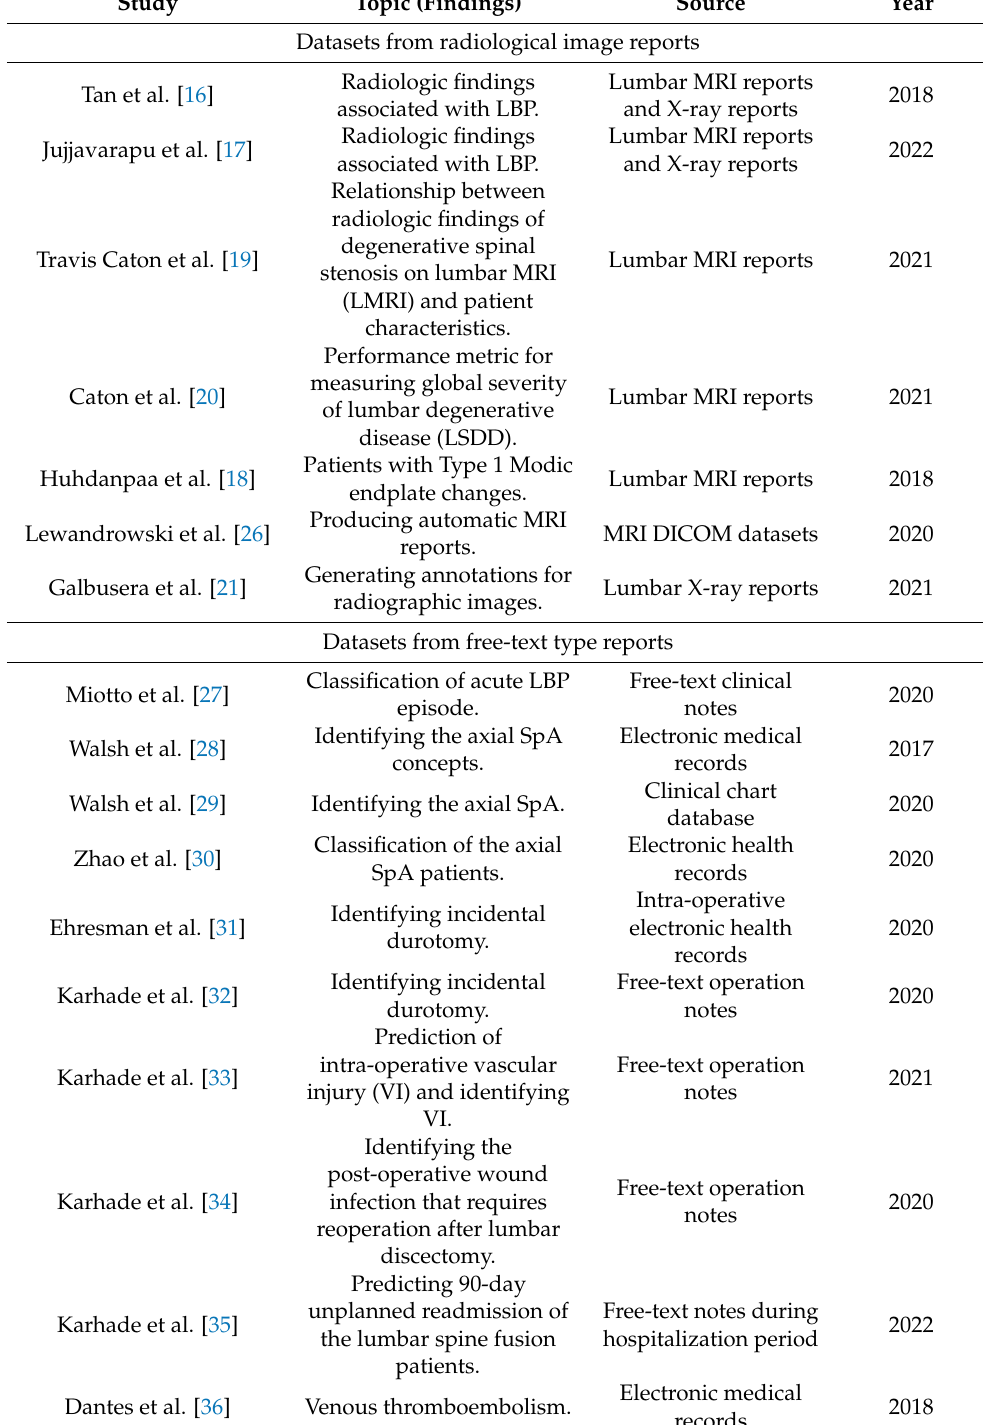
Table 4. Classification of previous studies to develop NLP systems regarding LBP pain, spinal disease, and complications of spinal